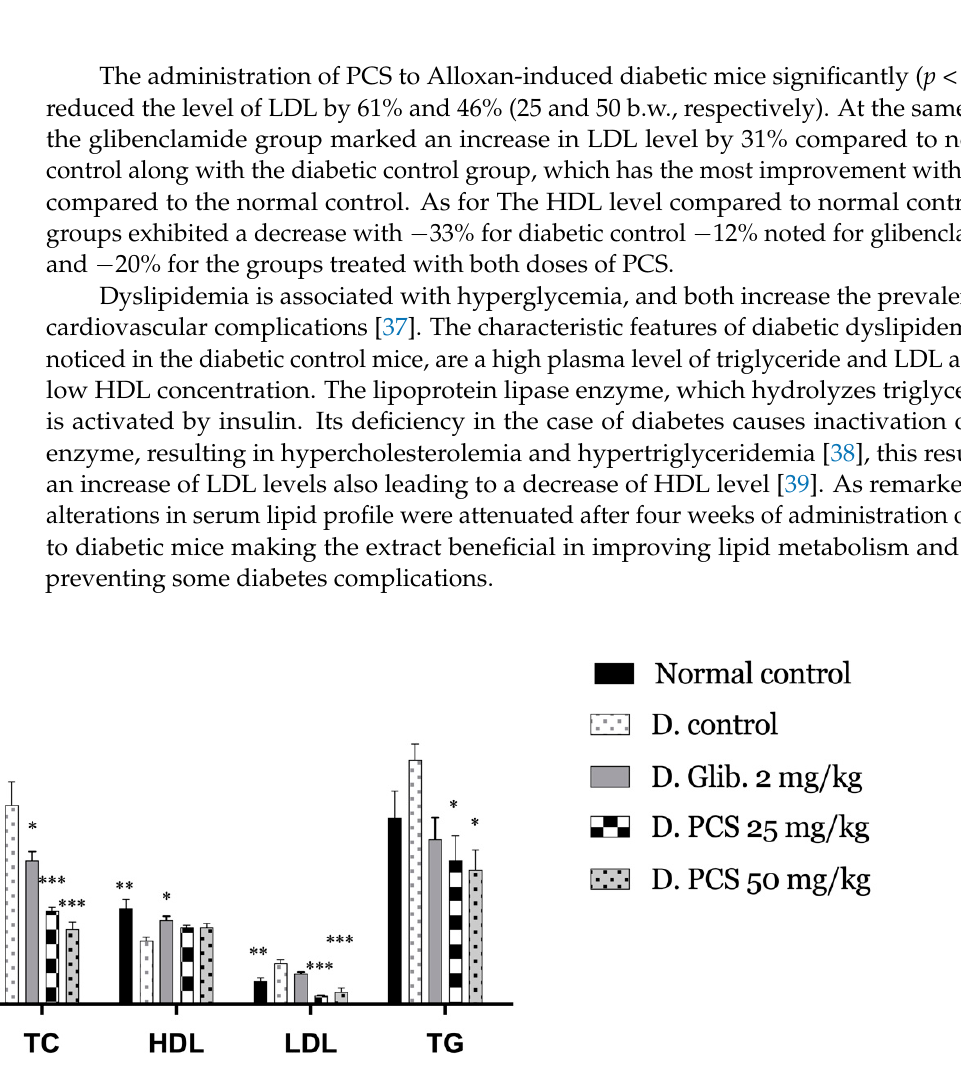
Figure 5. Effect of PCS on blood glucose level in Alloxan-induced diabetic mice during oral glucose tolerance (OGTT). Values are expressed as mean ±SD ( n = 5 mice). *** p < 0.001compared to normal control. 2.3. Anti-inflammatory Activity A progressive edema formation is due to the injection of carrageenan into the rat’s hind paw, reaching its maximum within the first 60 min. The inhibition rate of the treat- ments is shown in Figure 6. Within the first hour, the inhibition rate reached 29% for the group of rats treated with PCS at 25 mg/kg b.w. and 48% for the group treated with the dose of 50 mg/kg b.w. against 34% marked for the groups treated with Diclofenac. The inhibition rate continues to rise to reach at the 3rd hour 39, 55, and 57% for groups treated